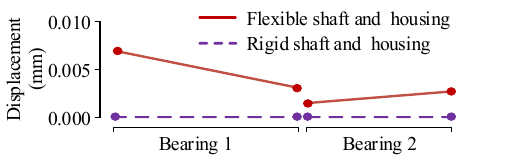
Figure 20. Relative position of the outer profiles of the outer rings of two bearings.